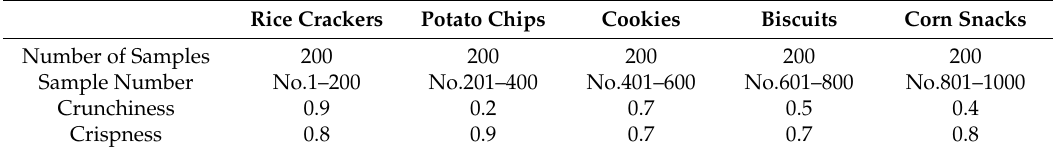
Table 1. Number and texture information of the snack samples.